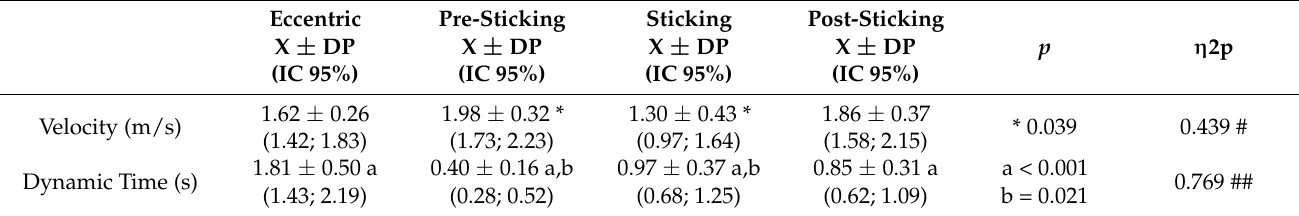
Table 2. Mean ± SD values and 95% confidence interval (CI 95%) of velocity and time to achieve eccentric, pre-sticking, sticking, and post-sticking in Paralympic Powerlifting.